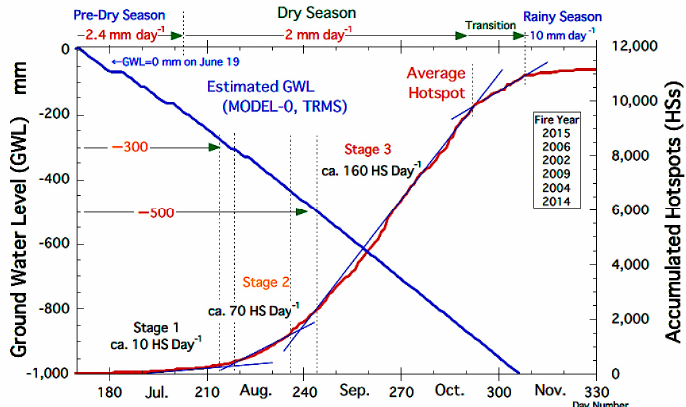
Figure 8. Average fire activity of El Niño fire year and estimated GWL using MODEL-0. Rainfall data from TRMS. GWL on June 19 (DN = 170) were set to 0 mm.